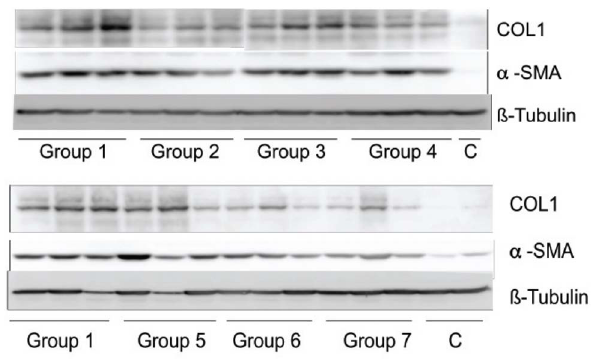
Figure 9. Western blot analysis of protein isolated from livers from animals in the experiment described in Figure 4. COL1=collagen type 1; a -SMA=alpha smooth muscle actin; C=normal rat liver protein; b -tubulin was used as an internal control.